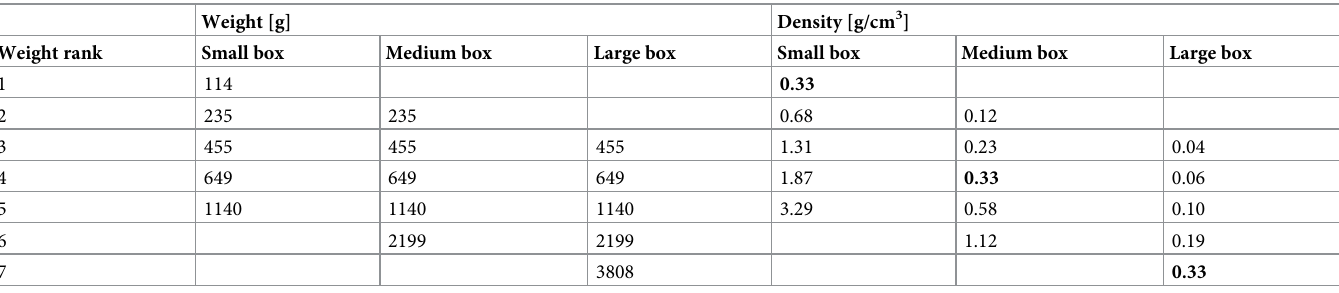
Table 1. Weight and density of the boxes used as stimuli in the experiment.